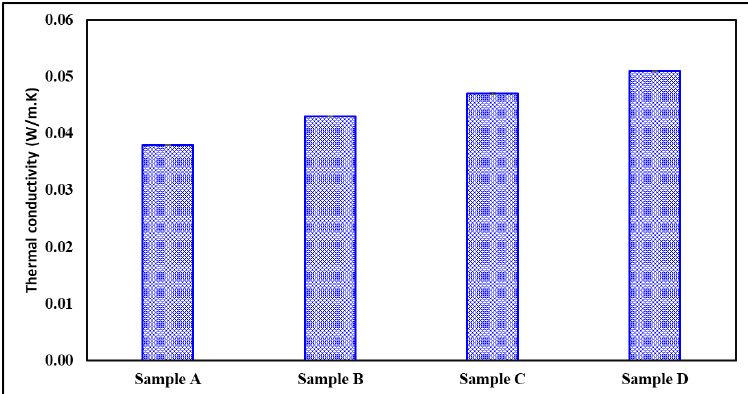
Figure 5. Thermal conductivity of four insulation composites based on three triplicates.